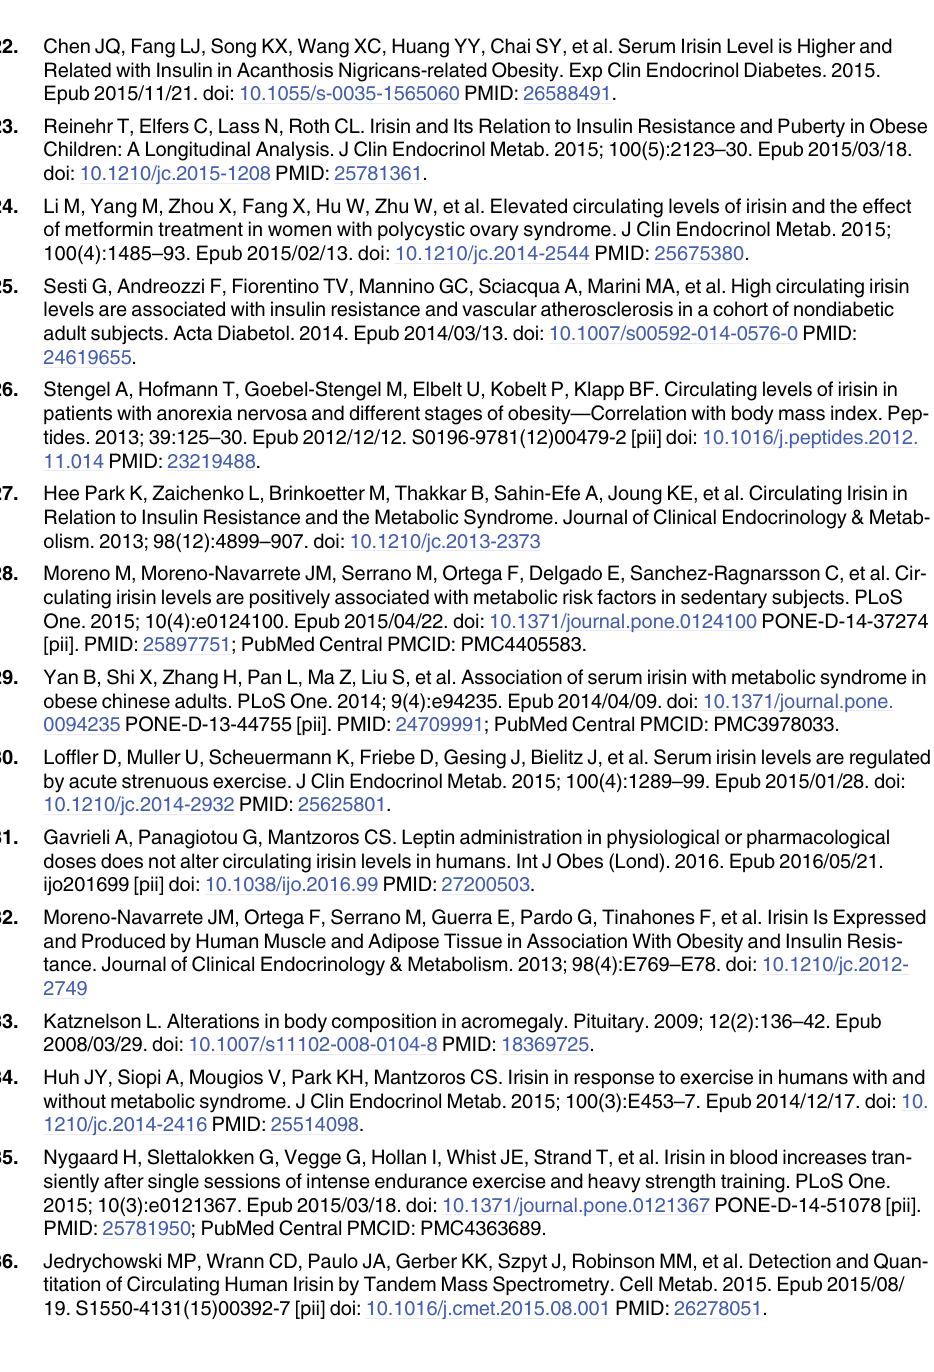
PLOS ONE | DOI:10.1371/journal.pone.0160364 July 29,